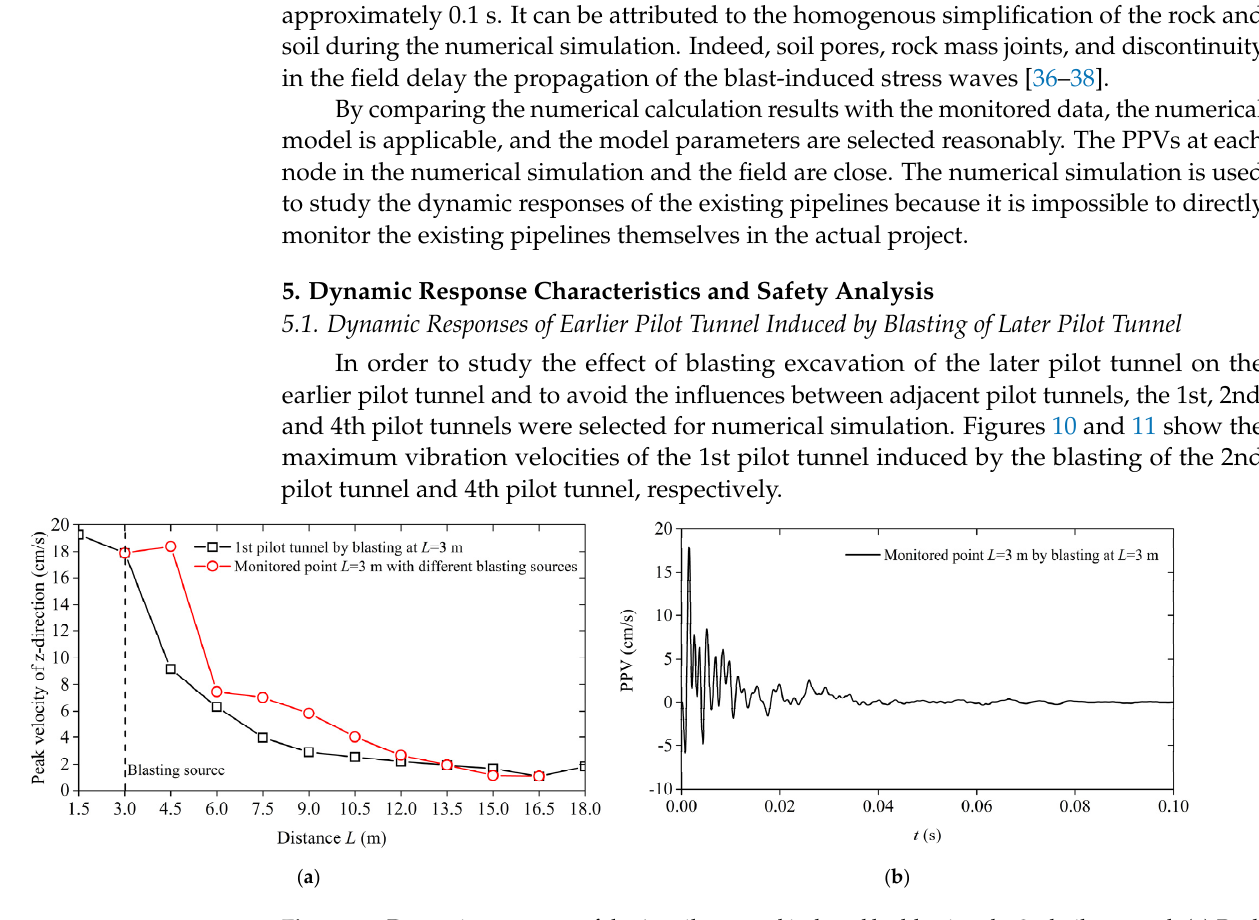
Figure 10. Dynamic responses of the 1st pilot tunnel induced by blasting the 2nd pilot tunnel: ( a ) Peak velocity of x-direction; ( b ) PPV of monitored point L = 3 m.